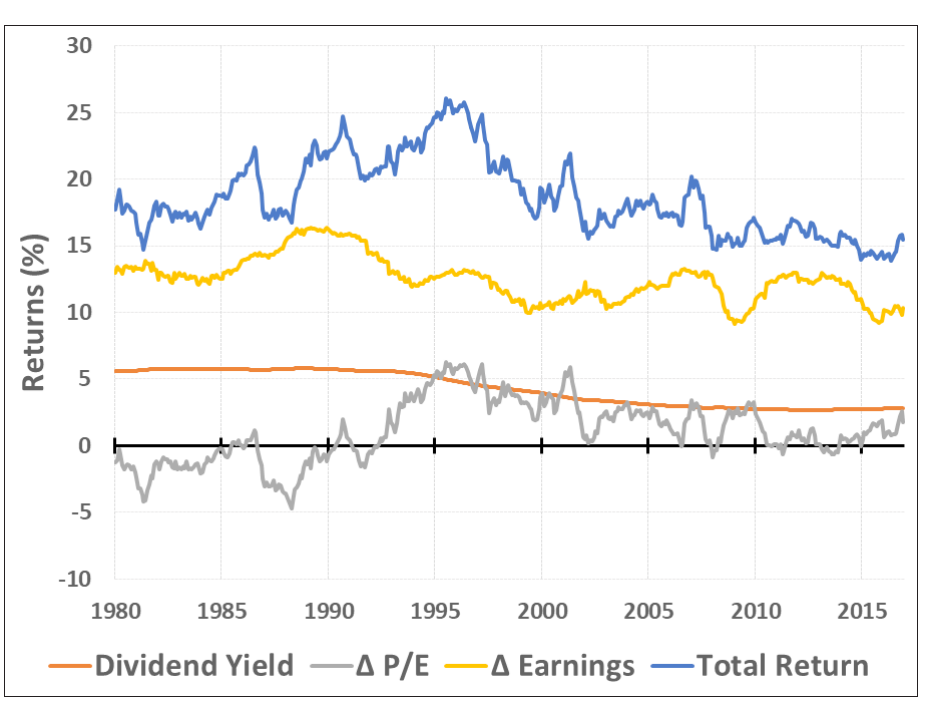
Figure 1: Decomposition of total index returns over rolling 20-year